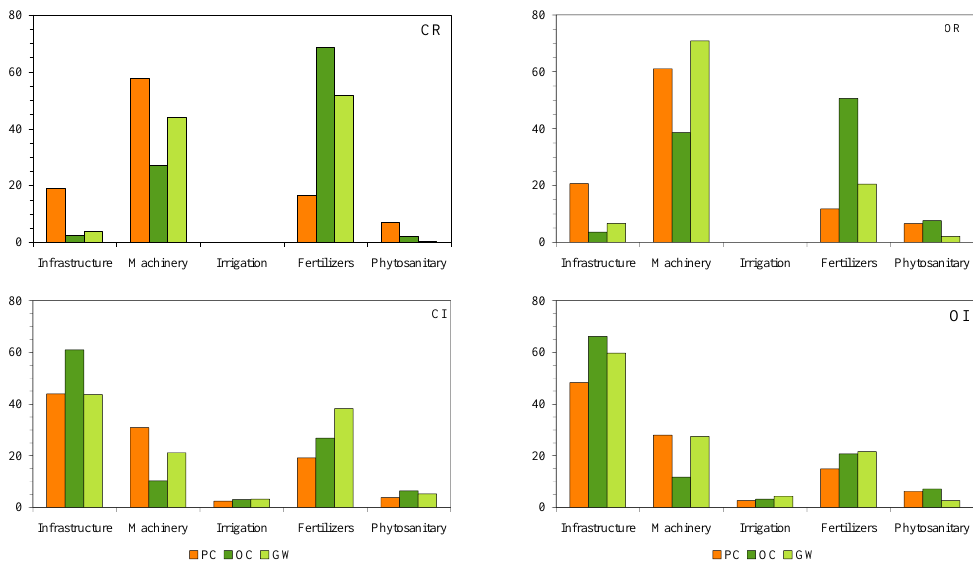
Figure 4. Contributions of the system components to the production costs (PC), environmental im- pacts (overall contribution, OC), and global warming (GW). In the production costs, each contribution was calculated without taking into account those aspects that do not represent an environmental impact (manpower, pruning, etc.). CR: conventional rainfed. OR: organic rainfed. CI: conven- tional irrigated. OI: organic irrigated.